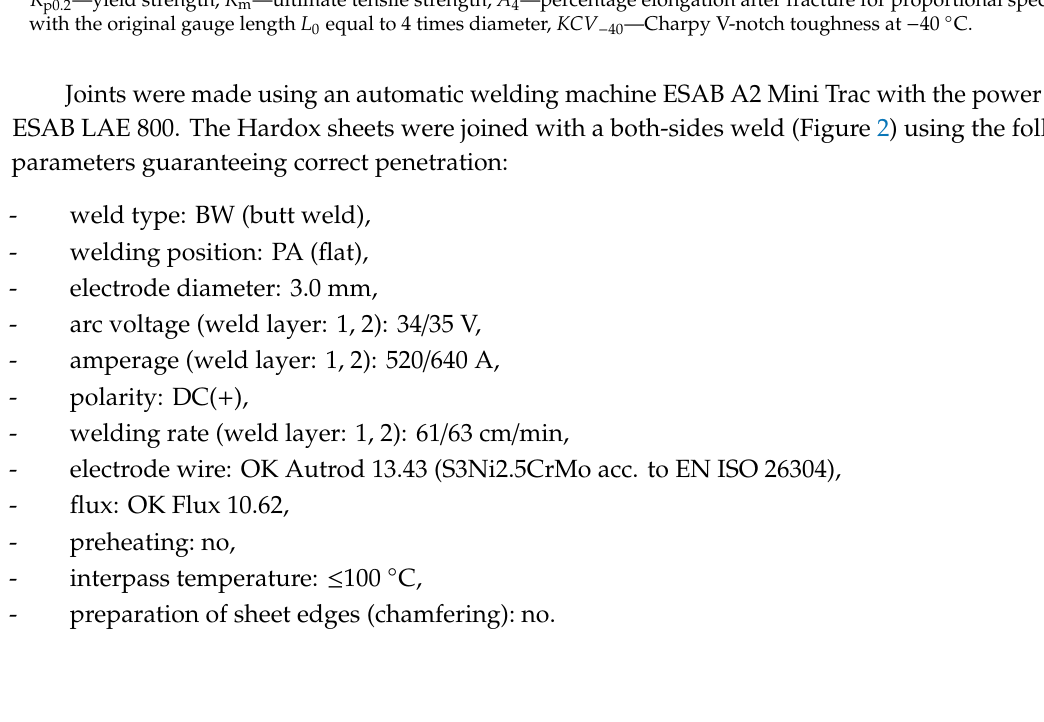
Table 4. Selected properties of welding materials used for Hardox Extreme joints [28]. C Mn Si Cr Ni Mo R p0.2 R m A 4 KCV − Weld Metal Chemical Composition [%] [MPa] [%] [J / cm 2 ] OK Autrod 13.43 + OK Flux 10.62 0.11 1.50 0.25 0.60 2.20 0.50 700 800 21